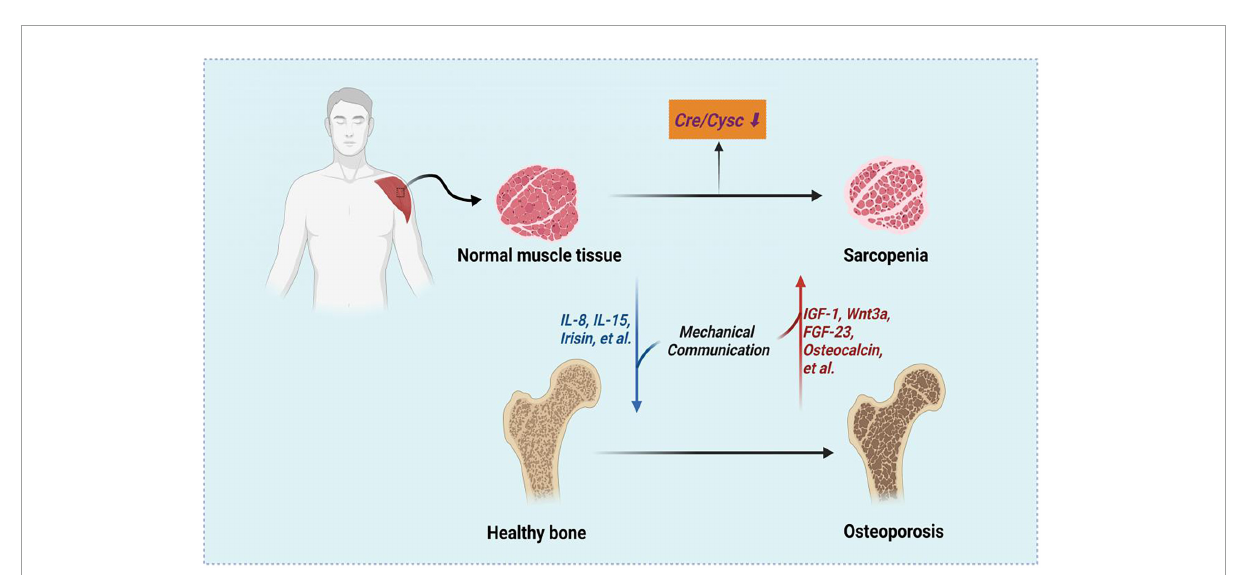
FIGURE3 The associations between Cre/CysC, sarcopenia and osteoporosis. Created with BioRender.com.